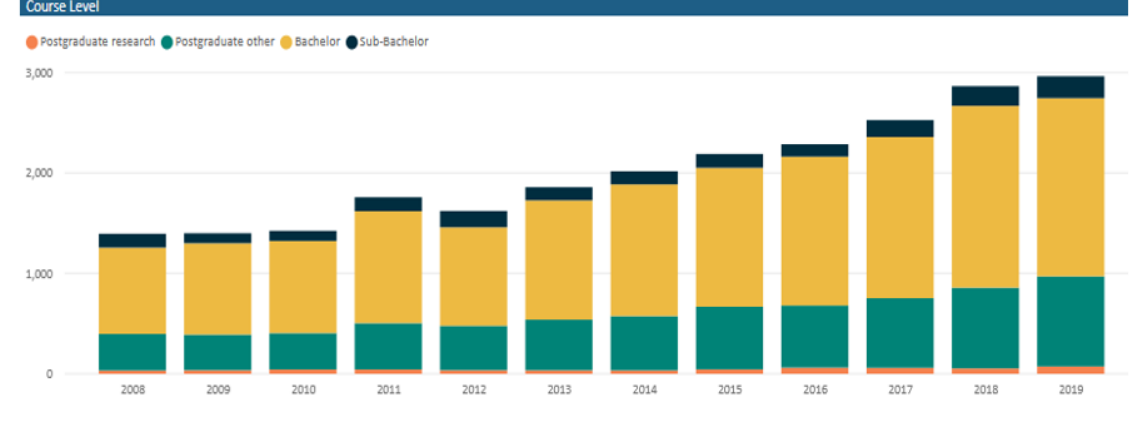
Figure 1. Number of Indigenous award course completions, by course